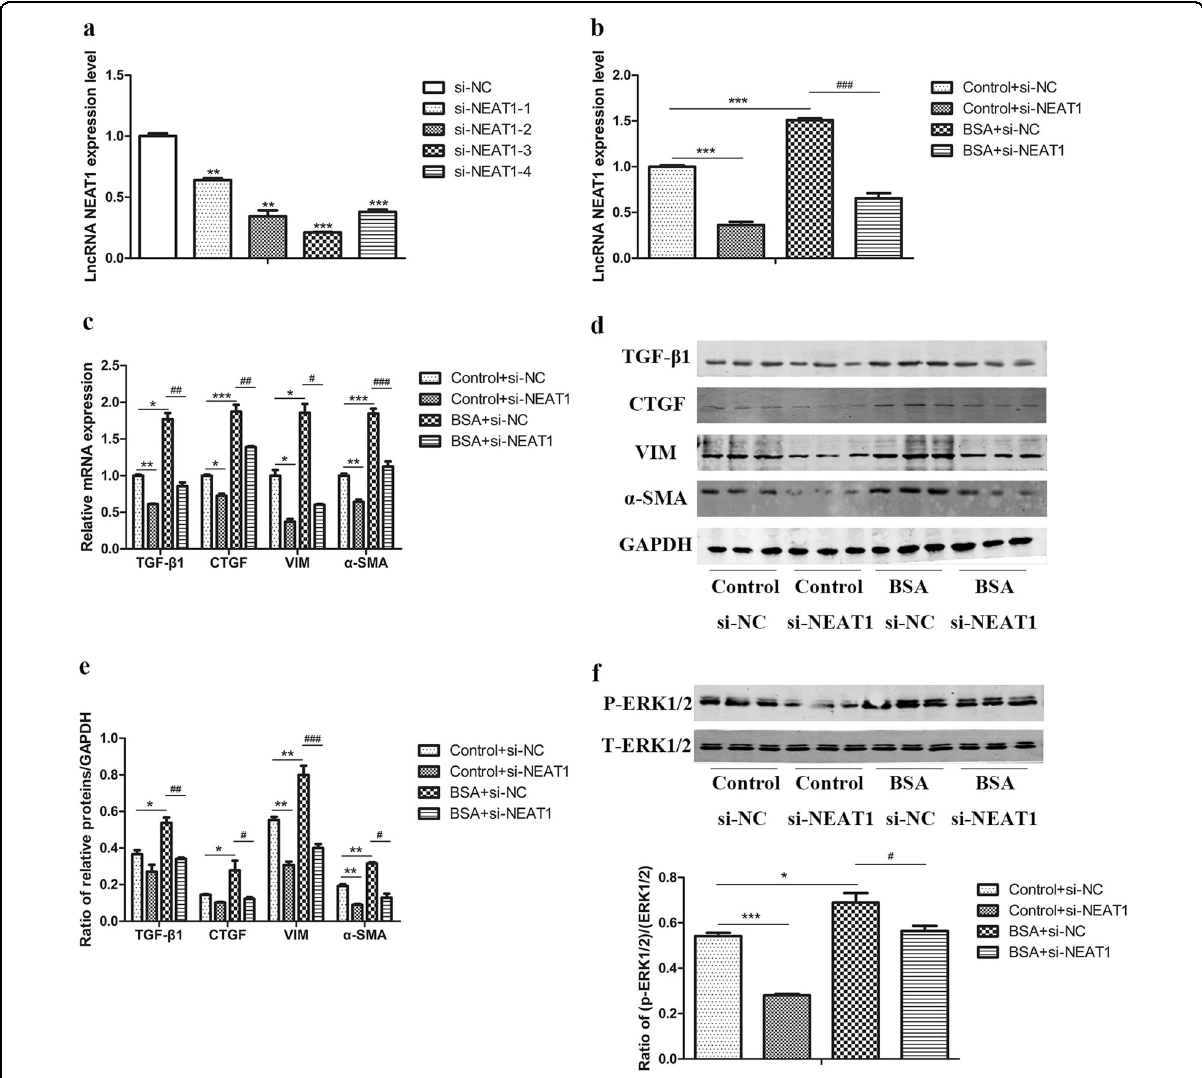
Fig. 4 Silencing of NEAT1 inhibited the expression of fi brosis factors and EMT markers in BSA-induced HK-2 cells. a qRT-PCR was performed to screen for NEAT1 siRNA in HK-2 cells. * p < 0.05 vs si-NC, ** p < 0.01 vs si-NC, *** p < 0.001 vs si-NC. HK-2 cells were transfected with si-NEAT1 and treated with 10 mg/ml BSA for 48 h. b , c lncRNA NEAT1 expression and the mRNA levels of TGF- β 1, CTGF, vimentin, and α -SMA were measured by qRT-PCR. d , e The protein levels of TGF- β 1, CTGF, vimentin, and α -SMA were measured by western blots. f Expression of total and phosphorylated ERK1/2 protein was detected by western blots. * p < 0.05 vs control + si-NC, ** p < 0.01 vs control + si-NC, *** p < 0.001 vs control + si-NC; # p < 0.05